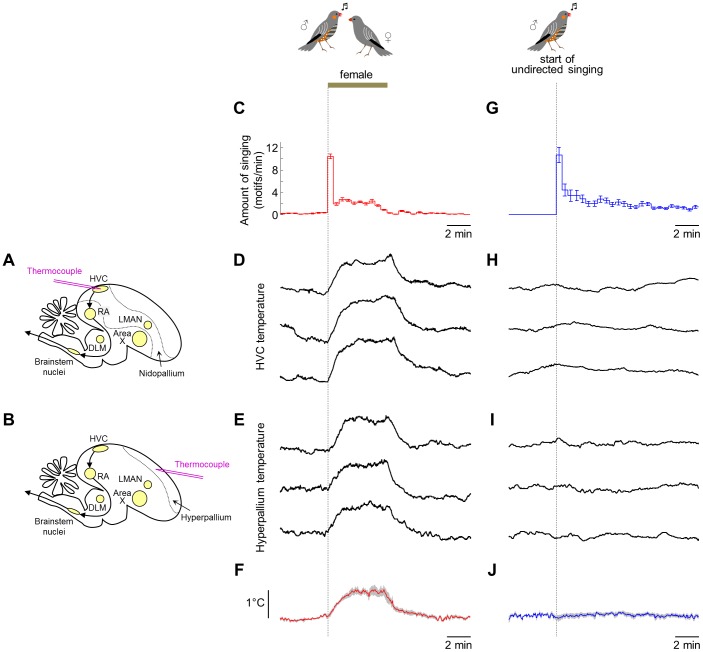
Brain temperature in male zebra finches rises in response to presentation of a female bird.(A, B) Schematic diagrams of the implantation of a thermocouple for temperature measurements. (A) A thermocouple was implanted into HVC along the approach angle shown. Yellow ovals indicate major nuclei of the song system, and arrows indicate the motor pathway. (B) In other experiments, a thermocouple was implanted into the hyperpallium, outside of the song system. Dotted line indicates boundary of the hyperpallium. (C) Average amount of singing triggered by presenting a female bird to the male. Error bars are SEM across all birds. (D) Examples of temperature recordings in HVC of bird #3 during individual trials in which a female bird was presented to the male for 5 min. (E) Examples of temperature recordings in the hyperpallium of bird #5 during presentations of a female. (F) Average temperature change across all 8 male birds during presentations of a female. Shaded area is SEM across all birds. (G) Average amount of singing produced in social isolation aligned to the onsets of the epochs of undirected singing. Epochs were defined as singing periods preceded by at least 20 min without singing. (H) Examples of HVC temperature recordings from the same bird as in (D) during epochs of undirected singing. (I) Examples of hyperpallium temperature recordings from the same bird as in (E) during epochs of undirected singing. (J) Average temperature change in all 7 birds during epochs of undirected singing. For all averages, data were first averaged for each bird; mean values were then averaged across all 8 birds.